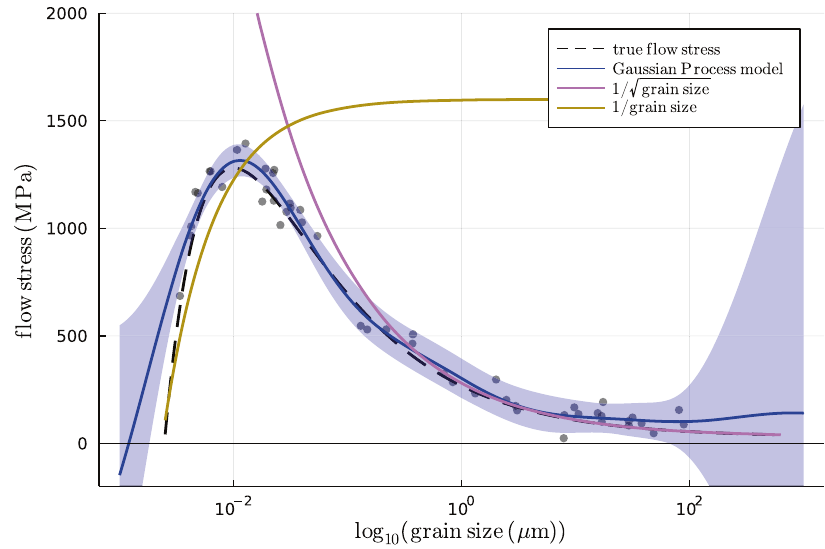
Fig. 2 Comparison of theoretical and ML Models of the Hall-Petch effect. The success of a given ML model may have little or no relationship to the actual physical processes as the model is merely interpolating between observations. For example, a Gaussian Process model can "capture'' the changeover in the behavior of the fl ow stress in metals from being dependent on grain boundary density in large-grain metals 78 to being dominated by grain boundary sliding in nanocrystalline alloys 79 even though the model is unaware of either mechanism. However, outside the range of acquired data the lack of encoding scienti fi c understanding results in rapidly increasing uncertainties, even in well-calibrated systems. Code for reproducing this fi gure is available at https://github.com/usnistgov/ml-materials-re fl ections 80